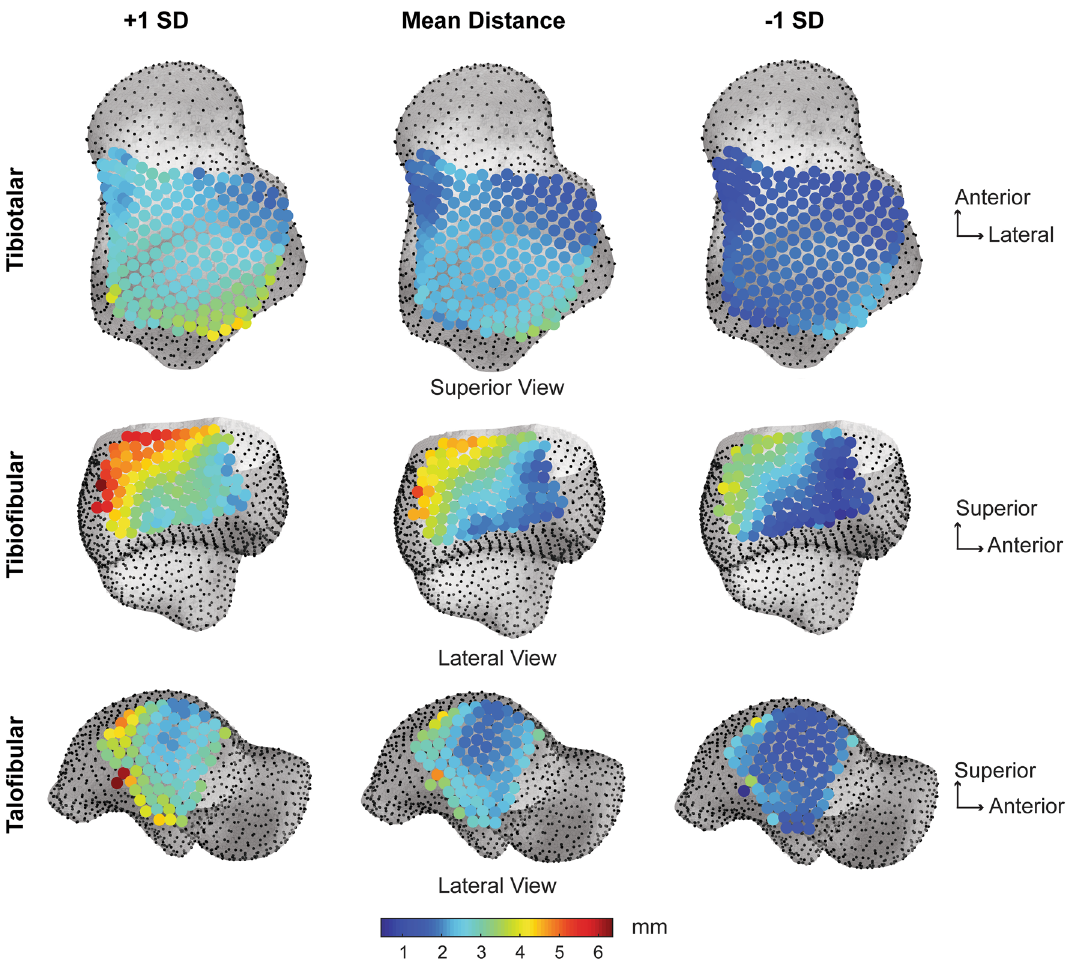
Figure 5. Average joint distance space with ± 1 standard deviation (SD) for the tibiotalar, tibiofibular and talofibular articular regions. Results are visualized on the mean shape correspondence